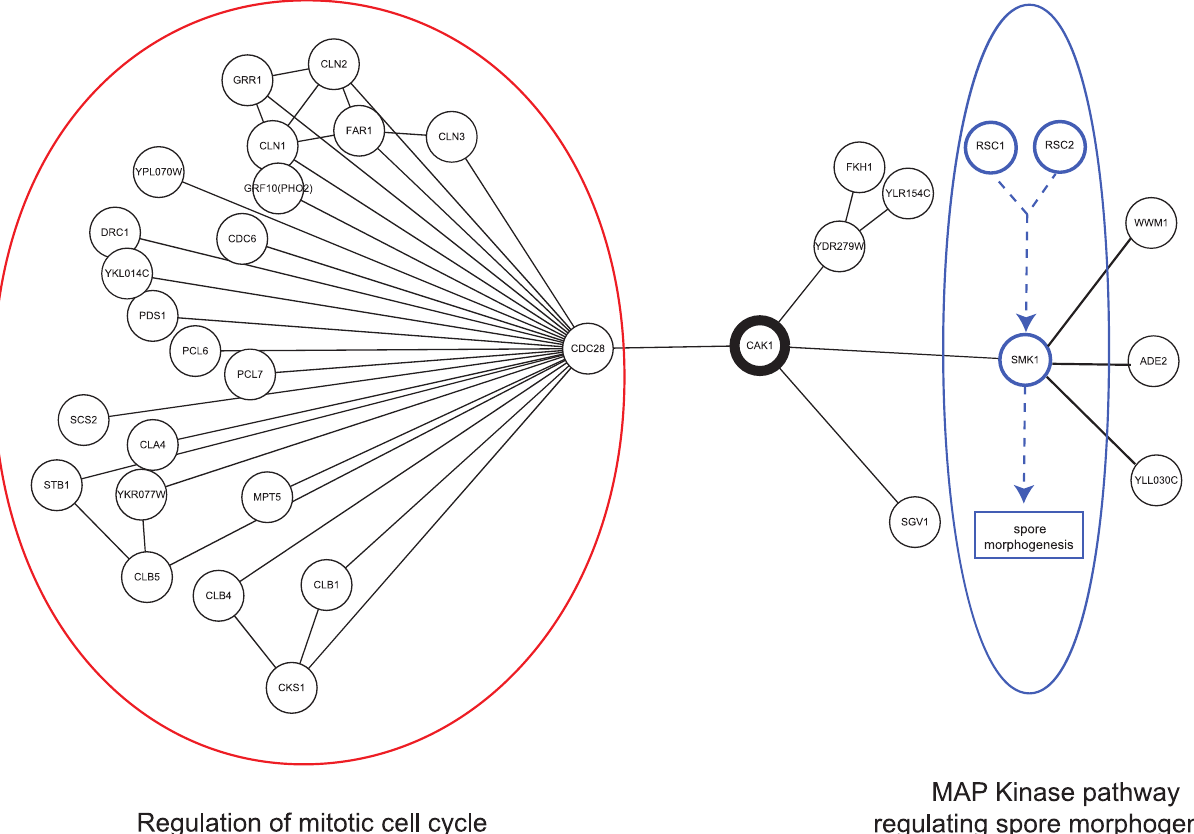
Figure 5. A Biological Example of a Nonhub–Bottleneck in the Interaction Network Cak1p is a cyclin-dependent kinase-activating kinase involved in two key signaling-transduction pathways: cell cycle and sporulation.